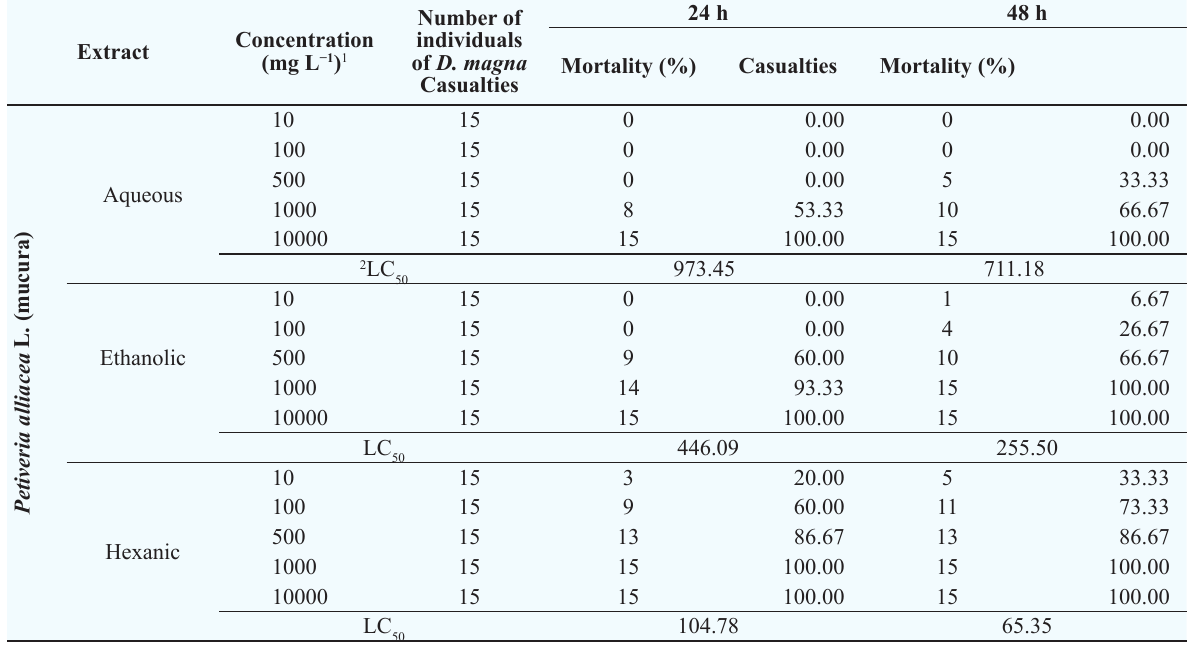
Table 2. Toxic effect of Petiveria alliacea L. (mucura) extracts in terms of mortality of Daphnia magna during 24 and 48 h of